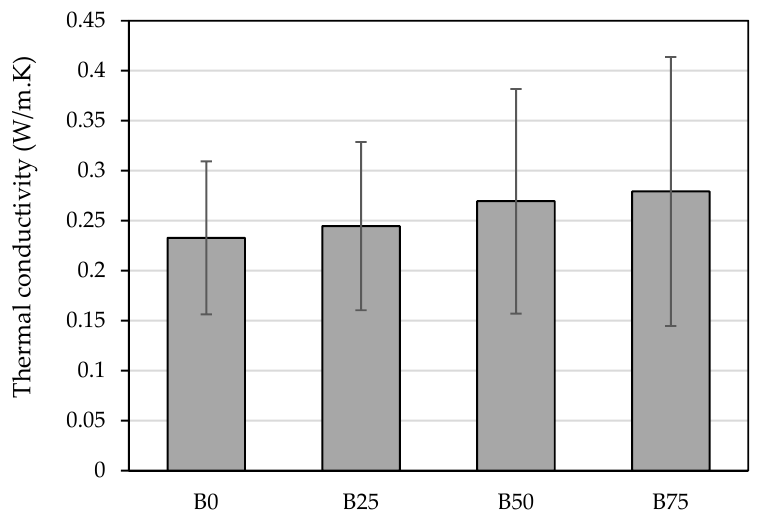
Figure 4. Average thermal conductivity results.